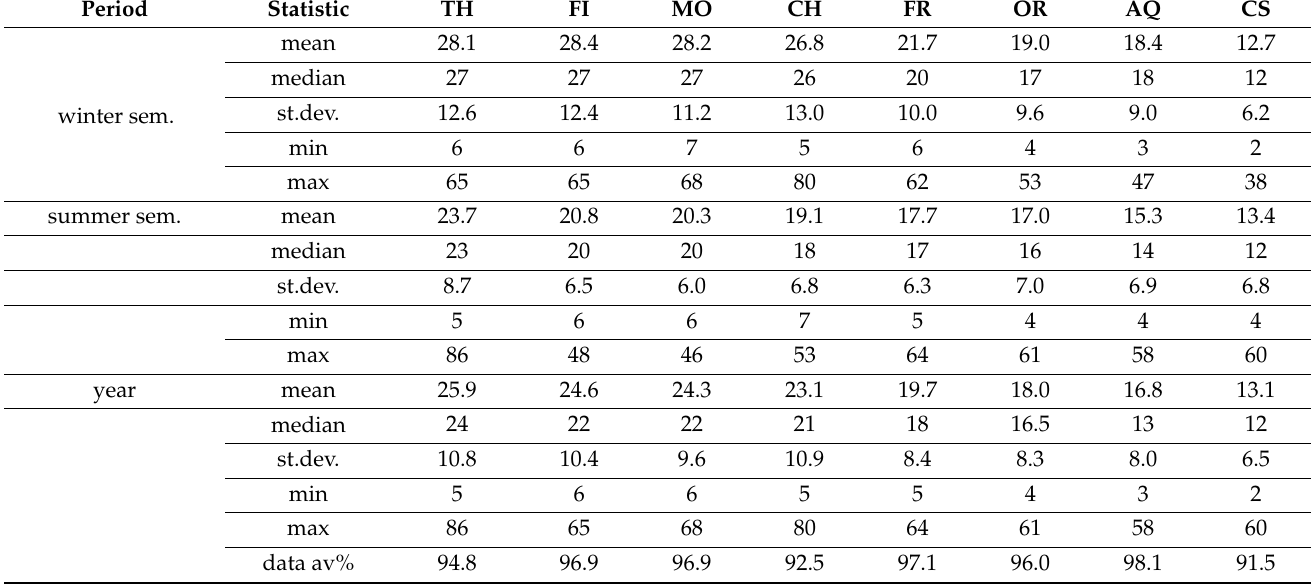
Table 3. Summary statistics for PM10 (expressed in µ g · m − 3 ) measured in the eight stations of the network in the two-year period 2017–2018, for summer semester (from April to September), winter semester (from October to March), and for the whole